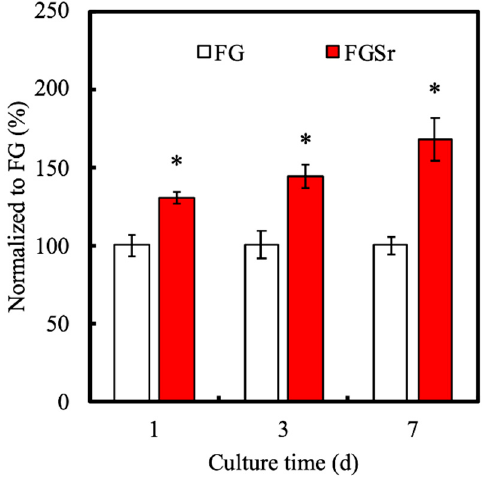
Figure 8. Proliferation of WJMSC on FG and FGSr scaffolds for 1, 3, and 7 days. Data presented as mean ± SEM, n = 6 for each group. “*” indicates a significant difference ( p < 0.05) when compared to FG.